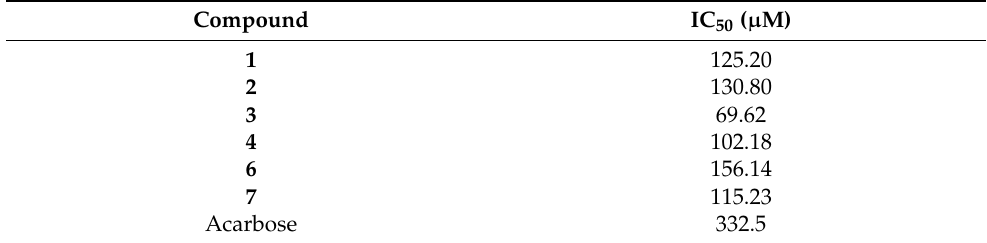
Table 1. Alpha-glucosidase inhibitory activity of 1–4 , 6 , and 7 .